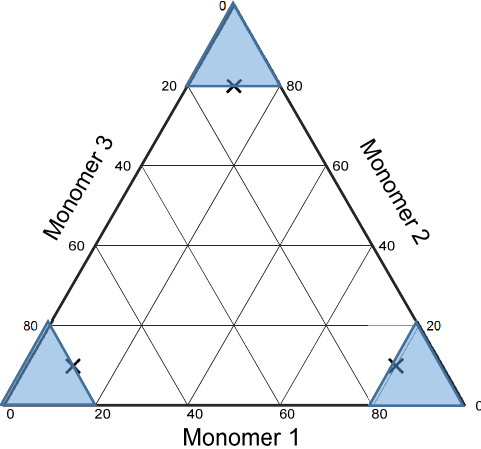
Figure 1. Optimally designed experiments for ‘ternary’ reactivity ratio estimation (as per [21]).